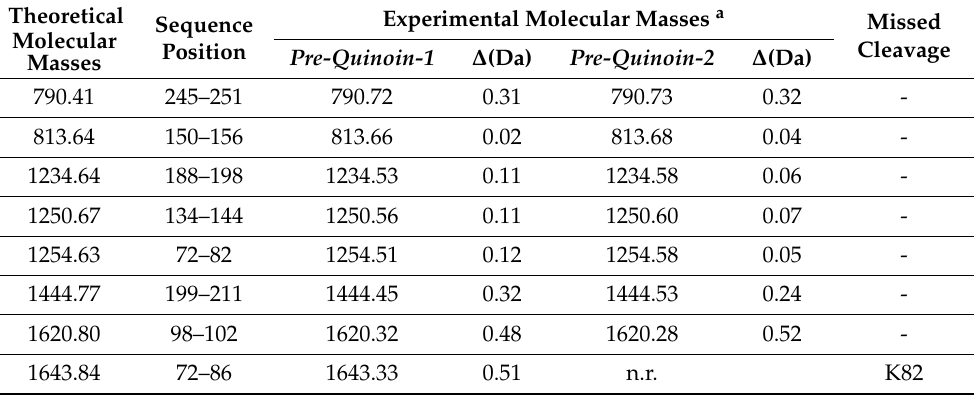
Table 3. MALDI-TOF-MS analysis of the peptide mixtures obtained by the trypsin digest of pre- quenoin-1 and pre-quinoin-2. The theoretical molecular masses were obtained from the quinoin sequence (see Figure